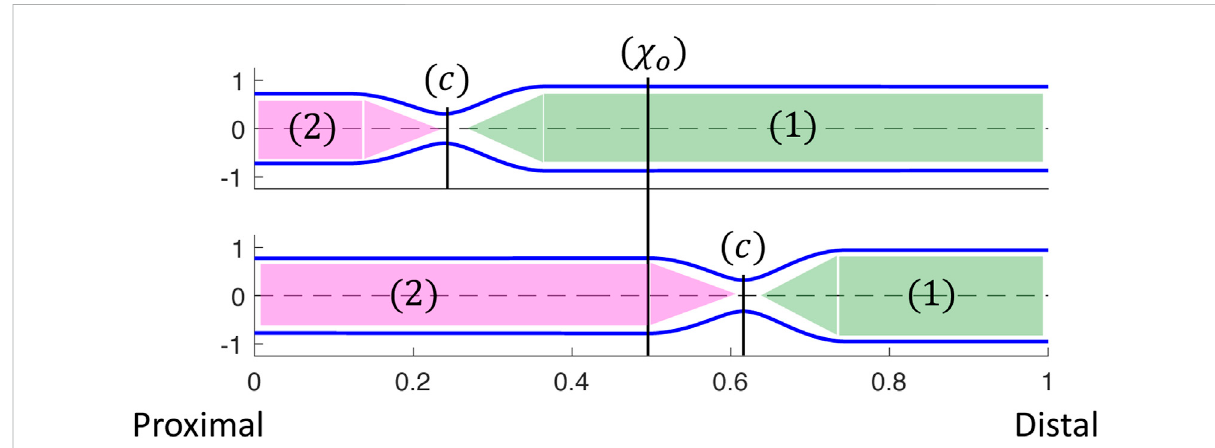
FIGURE 5 Two instants showing the corresponding tube shapes from the same simulation. The locations of point χ = c , regions 1 and 2, and how they change over time are depicted. P-CSA is plotted at χ = χ o and its location does not change with